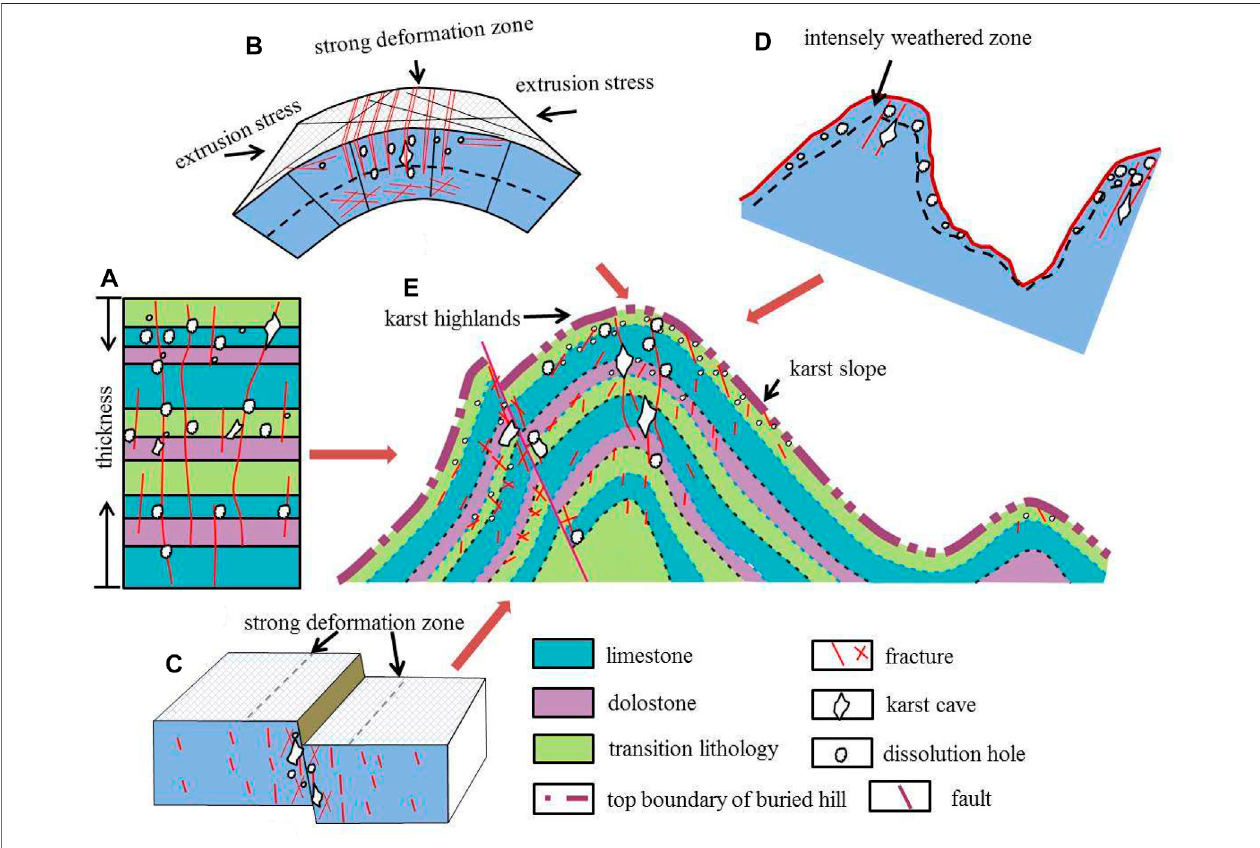
FIGURE 14 | (A) The controlling patern of lithology on fracture formation. (B) The controlling patern of structural deformation on fracture formation. (C) The controllingpaternoffaultingonfracture – cavereservoirsformation. (D) Thecontrollingpaternoftheancientkarstlandform onfracture – cavereservoirsformation. (E) The fracture – cave development patern of Weizhou 1-N oil fi eld.